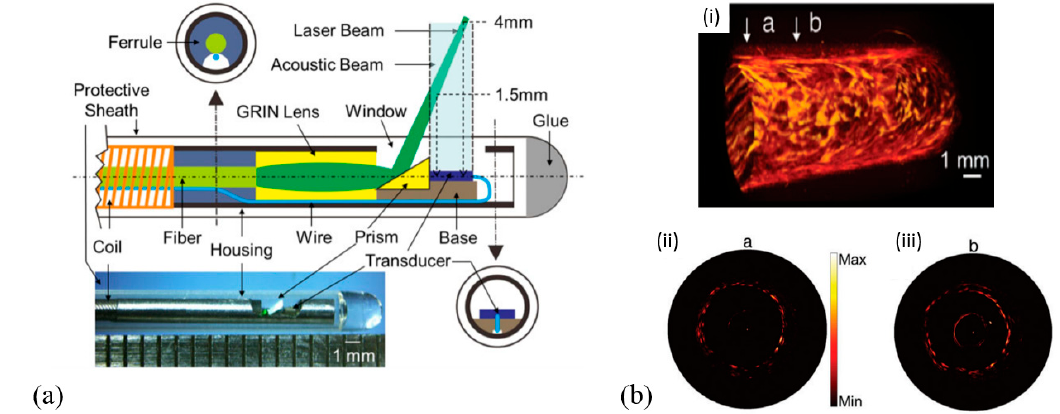
Figure 8. ( a ) Schematic (top) and photograph (bottom) of the photoacoustic/ultrasonic dual-modality endoscope. ( b ) Three-dimensional (3D) photoacoustic image of the rat’s rectum (b-i), and B-scan photoacoustic images of the “a” (b-ii) and “b” (b-iii) cross-sections (Reproduced with permission from John Wiley and Sons [24]).